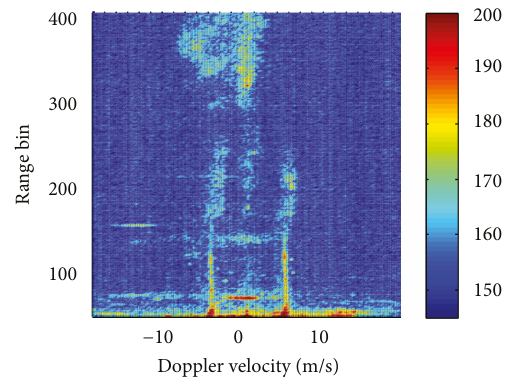
Figure 2: Range-Doppler spectrum of HFSSWR.